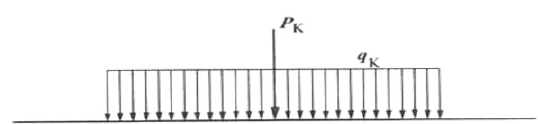
Figure 8. The static live